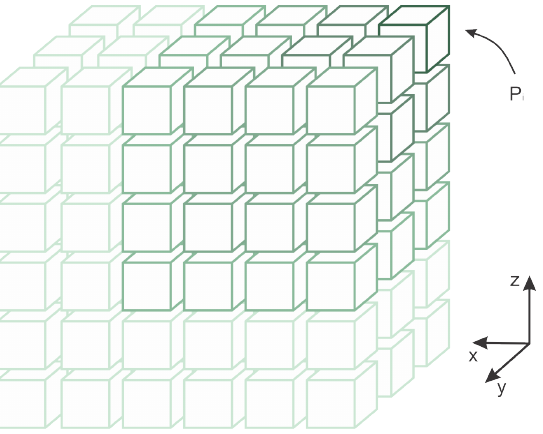
Figure 2. Cellular representation of the